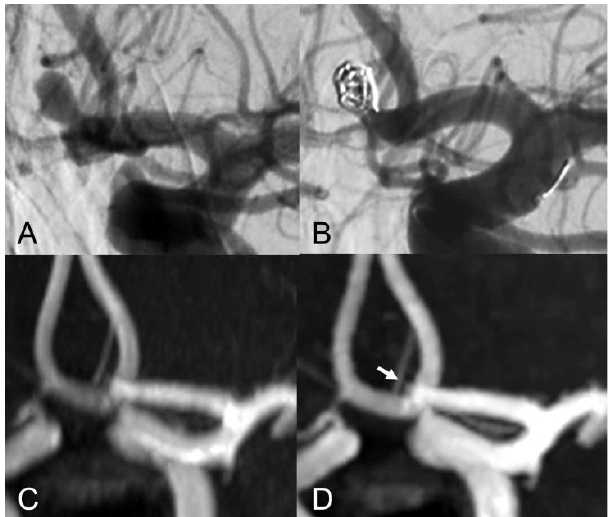
Figure 2. Lateral view of internal carotid artery DSA before ( A ) and after ( B ) anterior communicating artery aneurysm coiling. Coronal MIP images of PI TOF ( C ) showing complete occlusion of the aneurysm (class I) and CS TOF ( D ) better depicting a tiny neck residue (arrow), which was nonetheless correctly graded as class II only by the interventional neuroradiologist.